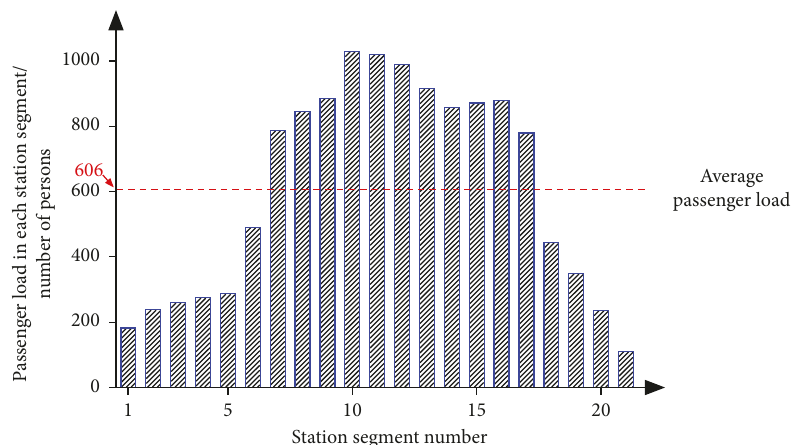
Figure 8: Passenger load in each station segment in the upstream direction at 17: 03.